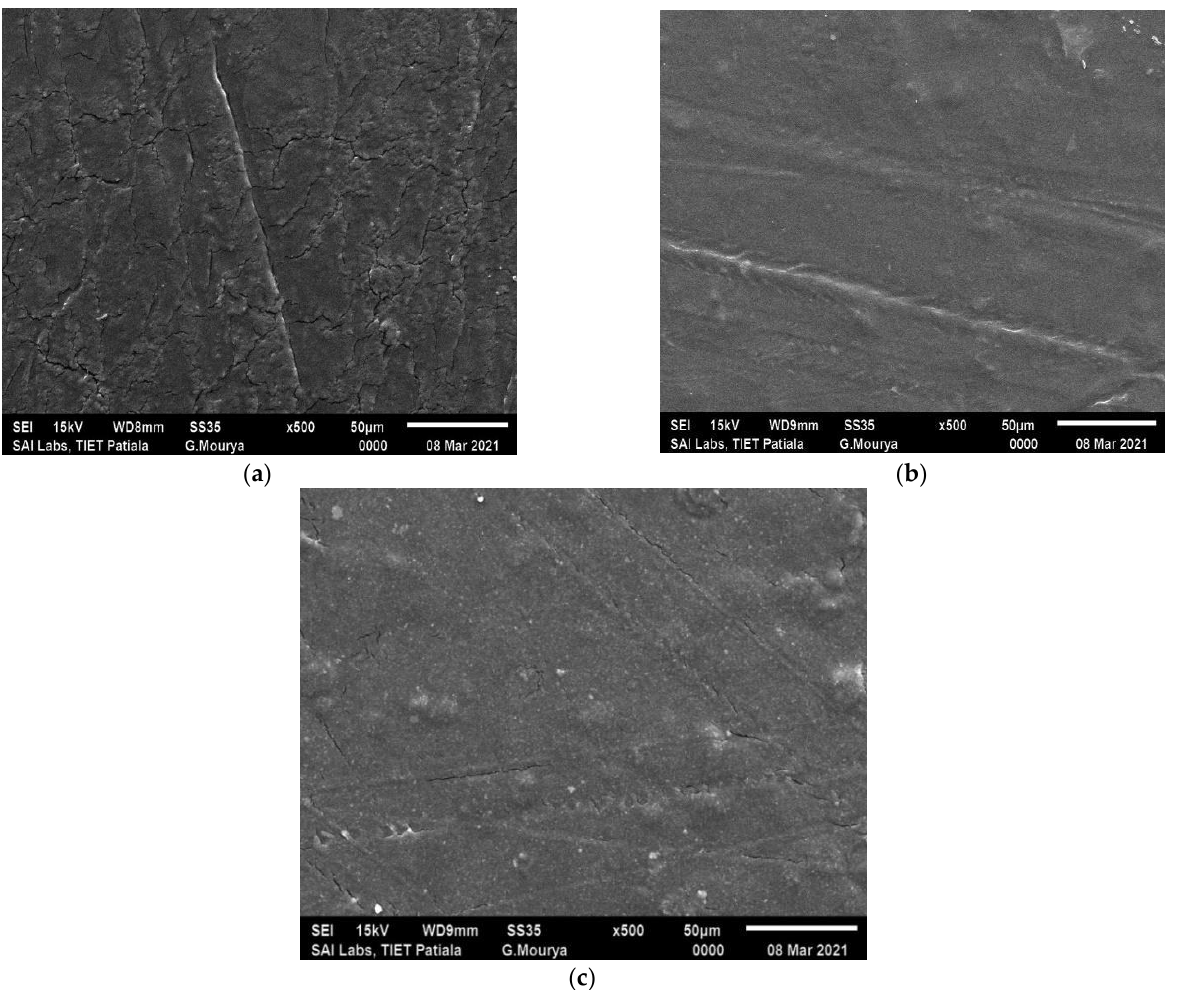
Figure 5. ( a – c ) Scanning electron microscopy of different types of films. ( a ) Composite film, ( b ) composite film with PVA, and ( c ) ZnO nanocomposite film.